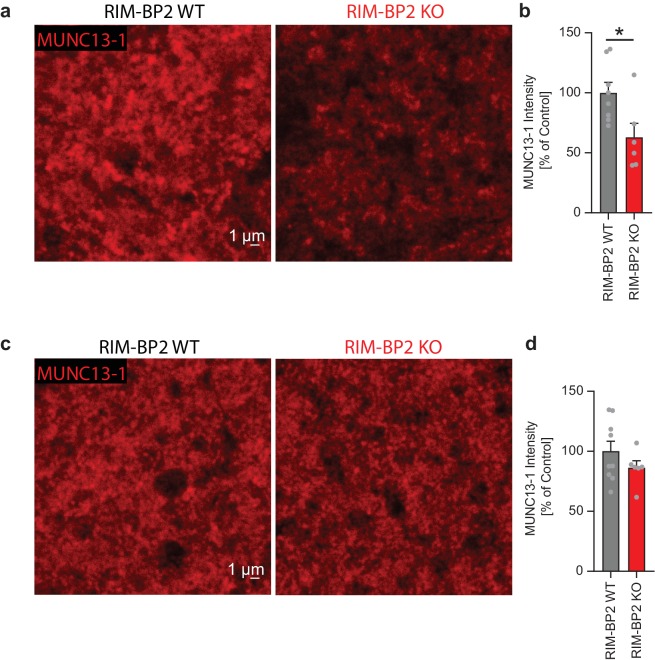
RIM-BP2 deletion results in significantly reduced Munc13-1 levels at MF synapses.(a) in situ confocal images of Munc13-1 immunoreactivity at MF synapses, in the CA3 stratum lucidum of RIM-BP2 WT (n = 8) and KO (n = 6) mice. (b) Munc13-1 intensity for MF synapses, normalized to RIM-BP2 WT mice. Loss of RIM-BP2 resulted in significantly lower Munc13-1 intensity in RIM-BP2 KO mice as compared to RIM-BP2 WT mice. (c) in situ confocal images of Munc13-1 immunoreactivity in the CA1 stratum radiatum (n(WT)=9; n(KO)=6). (d) Munc13-1 intensity for CA3-CA1 synapses, normalized to RIM-BP2 WT mice. At CA3-CA1 synapses, RIM-BP2 deletion did not significantly altered Munc13-1 intensity. Values represent mean ± SEM. *p<0.05. For statistics please see Figure 3—figure supplement 3—source data 1.10.7554/eLife.43243.014Figure 3—figure supplement 3—source data 1.Statistics of data presented in Figure 3—figure supplement 3.